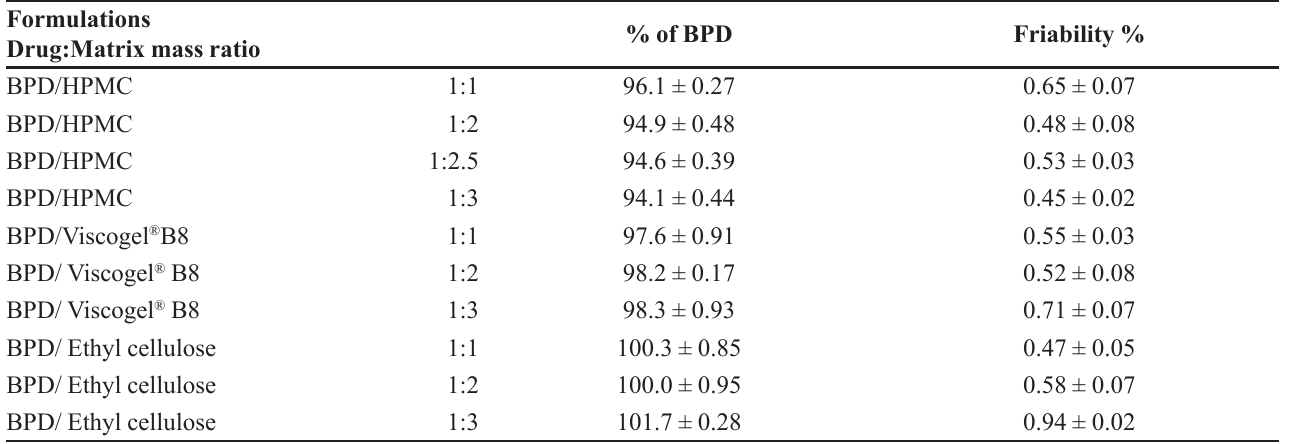
TABLE I - Composition and properties of different formulations of BPD matrix tablets